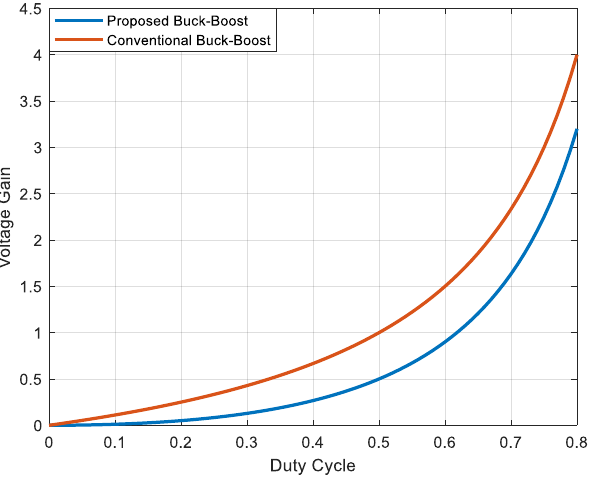
Figure 4. Voltage gains for the conventional and the extended buck region buck-boost systems.